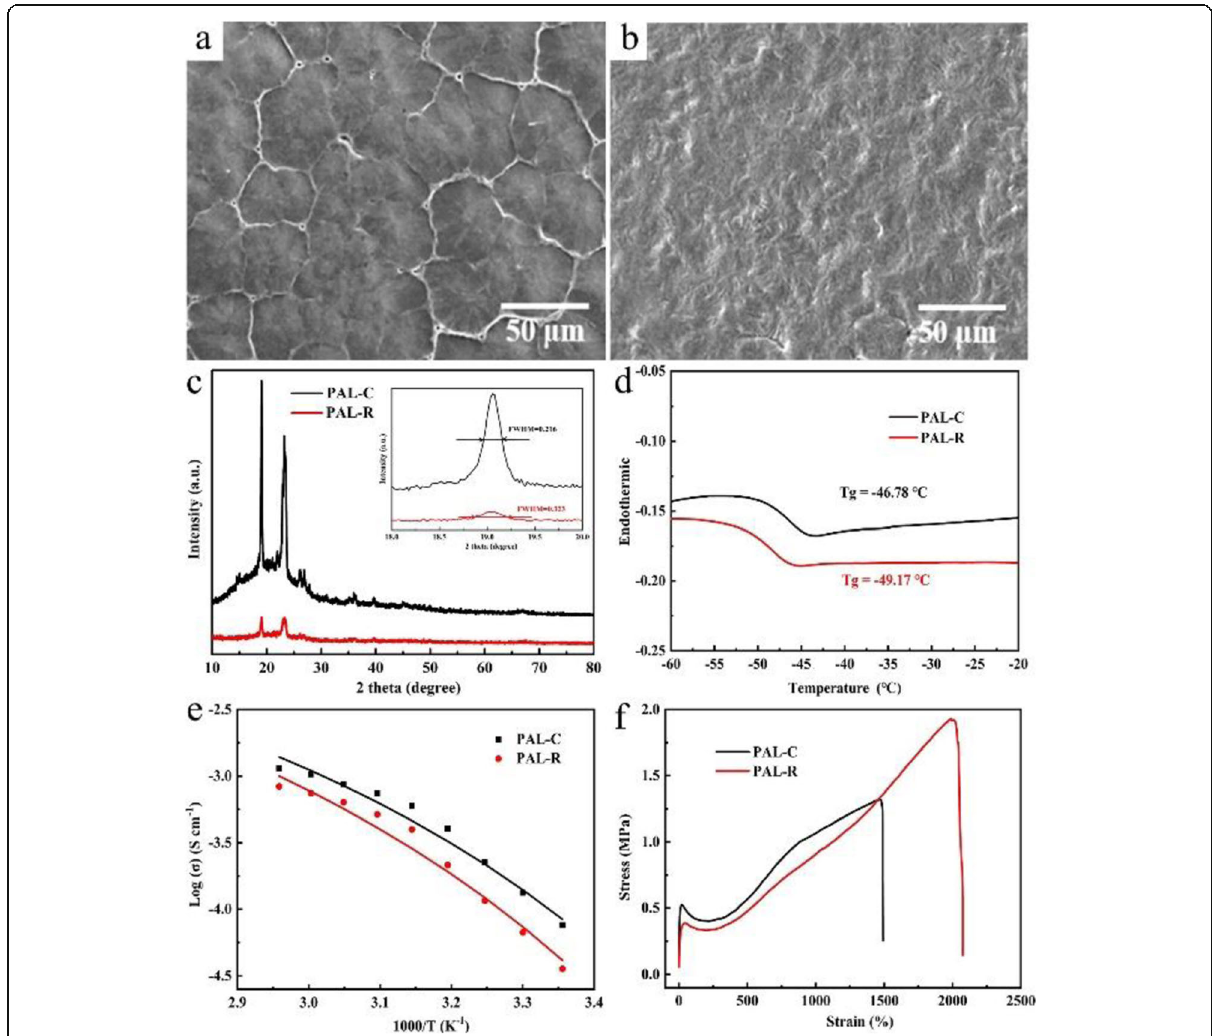
Fig. 1 Material characterization of different SPES: a , b SEM images of PEO grain in SPE before ( a ) and after ( b ) press rolling; c XRD patterns for different SPE (inset: the enlarged XRD peaks at 19.0°); d DSC profiles; e ionic conductivity; and f stress-strain curves of PAL-C and PAL-R